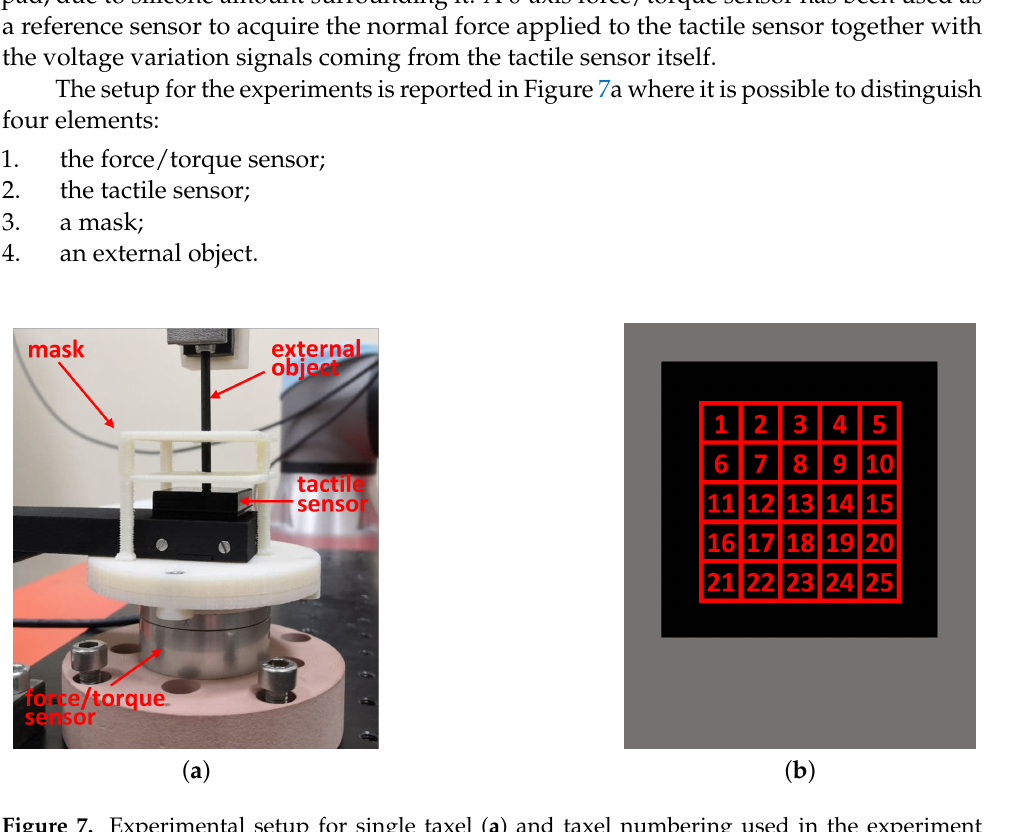
Figure 7. Experimental setup for single taxel ( a ) and taxel numbering used in the experiment description ( b